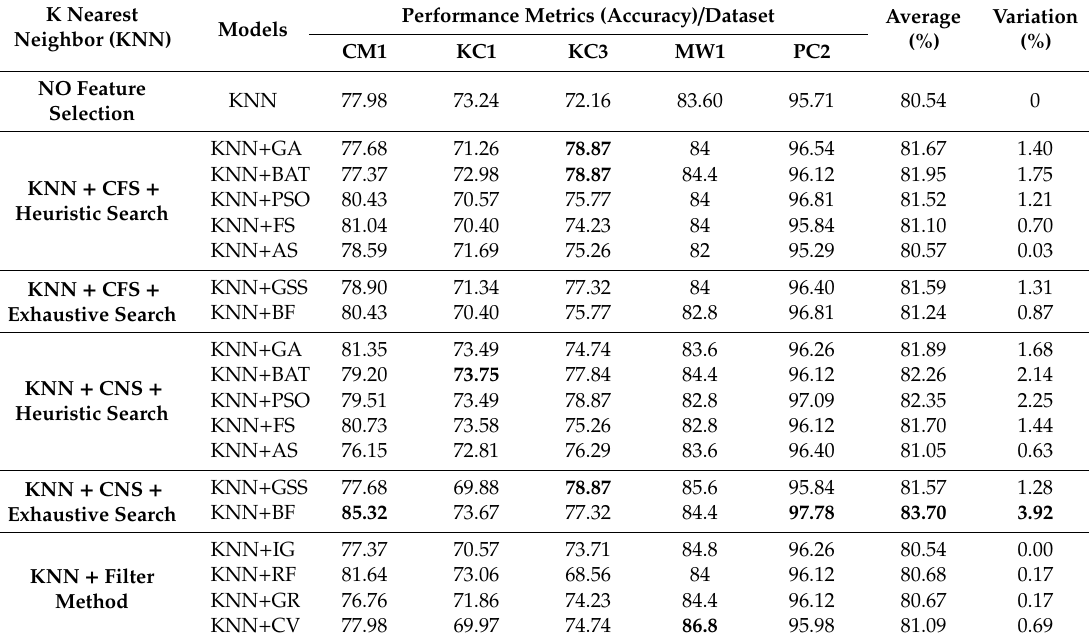
Table 9. Accuracy Values of K Nearest Neighbor Classifier on Full and Reduced Datasets.